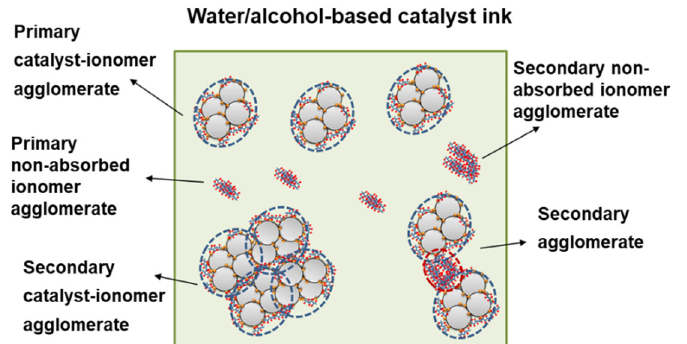
Figure 3. Illustration of the microstructure of the water/alcohol-based catalyst ink commonly used [21,51–55].